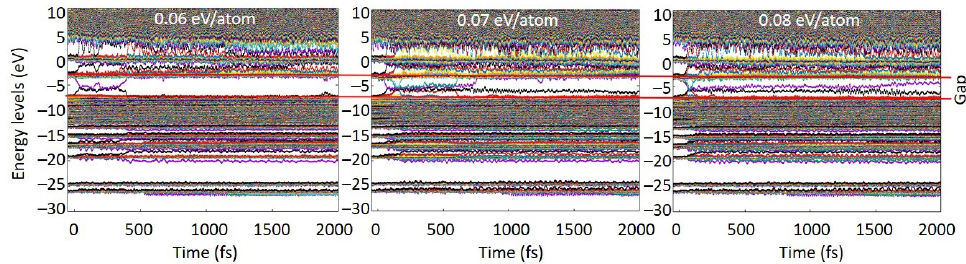
Figure 2. Evolution of the electronic energy levels (eigenstates; molecular orbitals) in PMMA irradi- ated with 0.06 eV/atom (left panel), 0.07 eV/atom (middle panel), and 0.08 eV/atom (right panel) deposited doses. Initial HOMO-LUMO gap is marked with red lines to illustrate formation of defect levels within the gap.